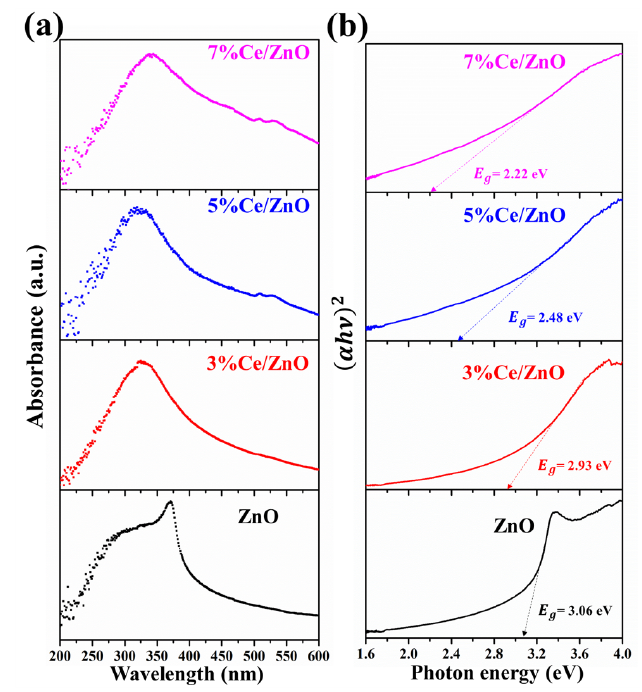
Figure 5. UV–visible spectroscopy of the pristine ZnO and Ce/ZnO samples: ( a ) Absorption spectra and ( b ) optical band-gap energy.